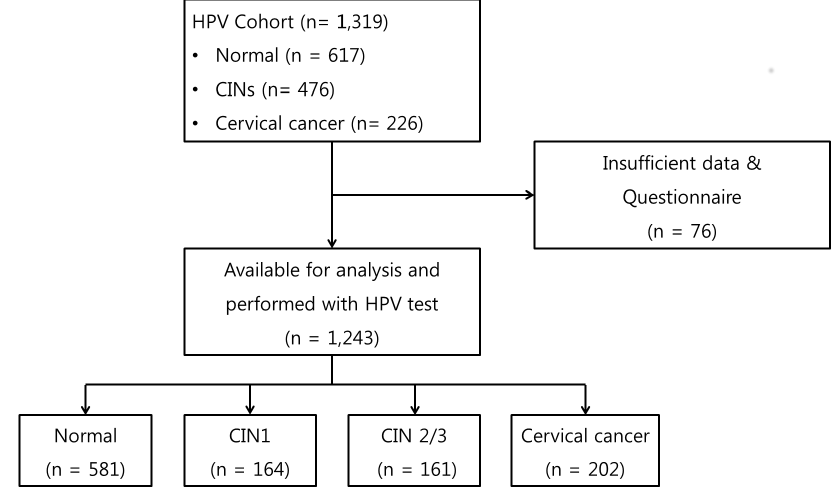
Figure 1. Study subjects enrolled in the present analysis.